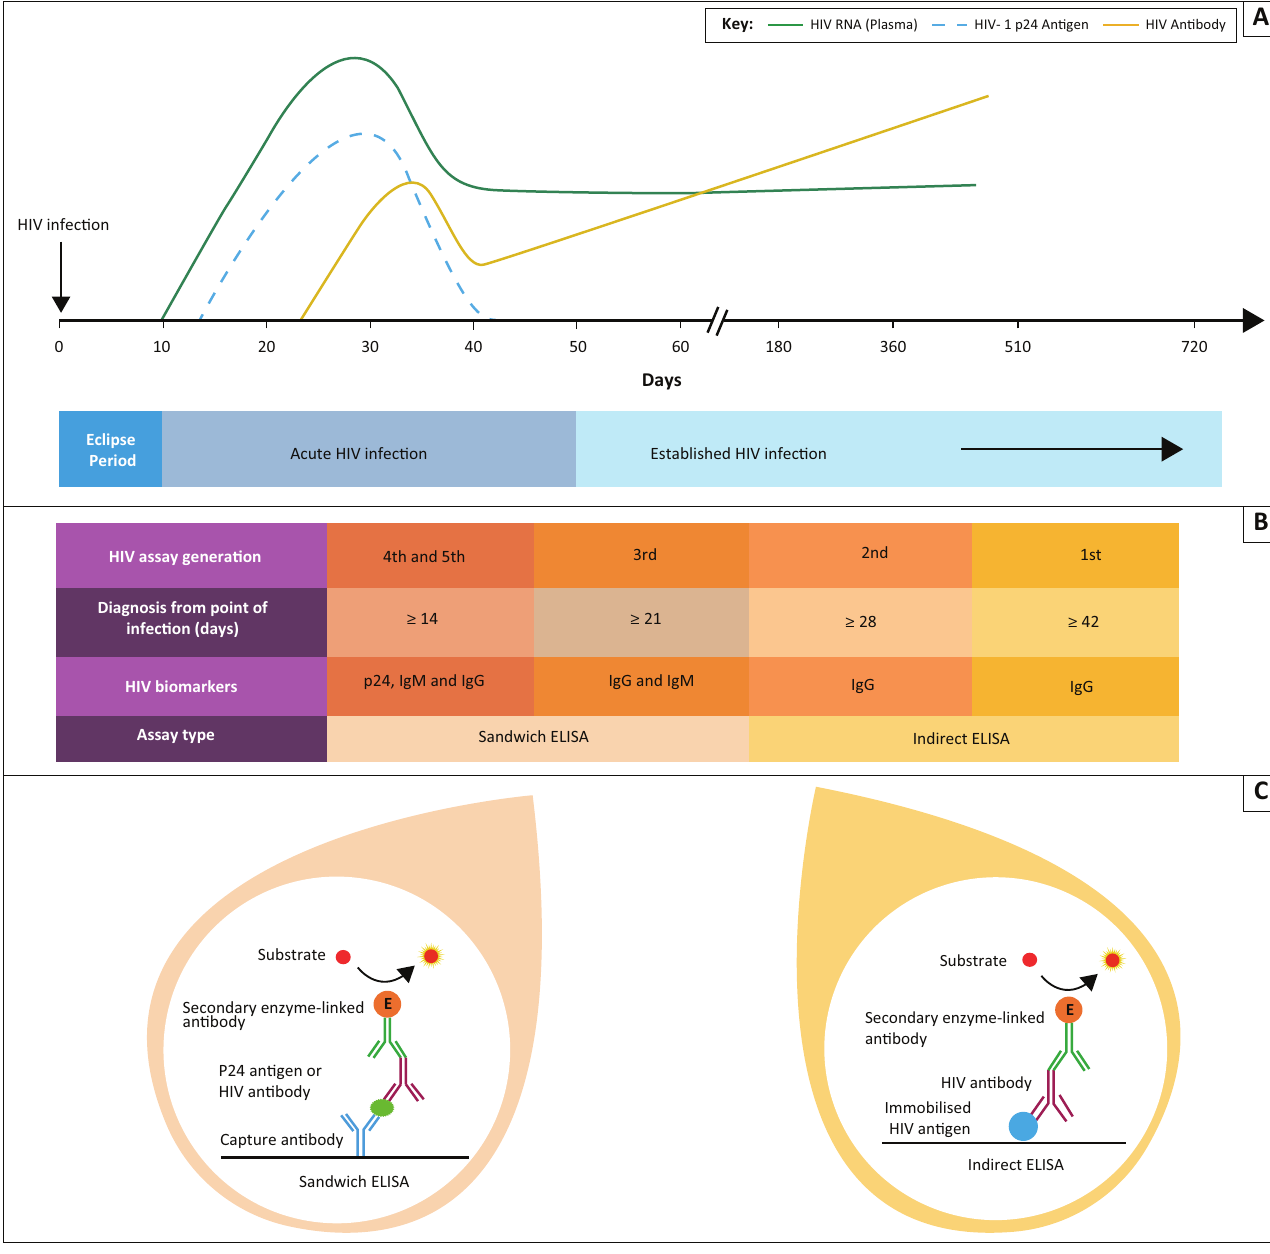
FIGURE 1 : Laboratory diagnosis of HIV infection in adults. (a) HIV diagnosis is made by detecting HIV biomarkers: HIV nucleic acid, RNA, HIV-1/2 p24 and HIV antibodies (Immunoglobin M and Immunoglobin G). (b) Technological evolution in HIV assay design has enabled early diagnosis from the point of infection. (c) Enzyme immunoassay used in HIV testing utilise enzyme-linked immunosorbent assay design. First- and second-generation HIV EIAs employ indirect enzyme-linked immunosorbent assay format in contrast to the sandwich enzyme-linked immunosorbent assay applied in the third-, fourth- and fifth-generation HIV